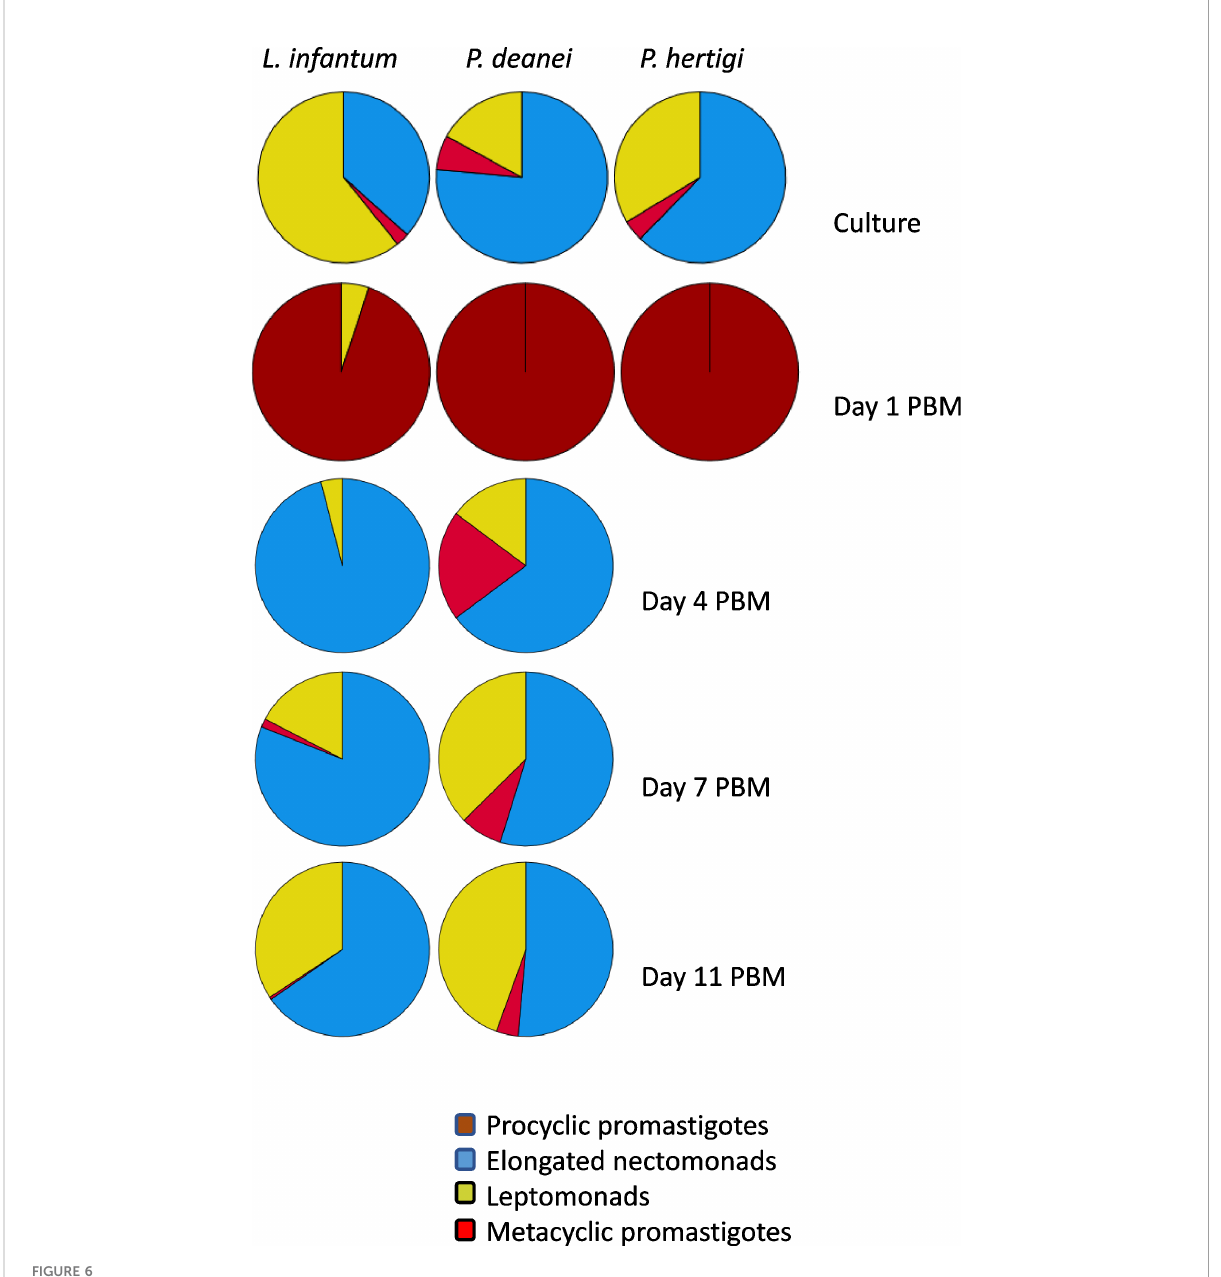
FIGURE 6 Representation of morphological forms on sand fl y guts smears. Haptomonads were not quanti fi ed because these attached forms are underscored on gut smears. The numbers of promastigotes can be found in Table 1.